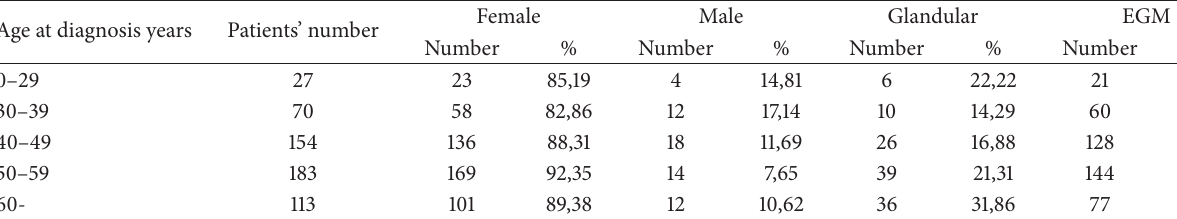
Table 2: Percentages of sex and clinical characteristics in patient groups stratified by age.